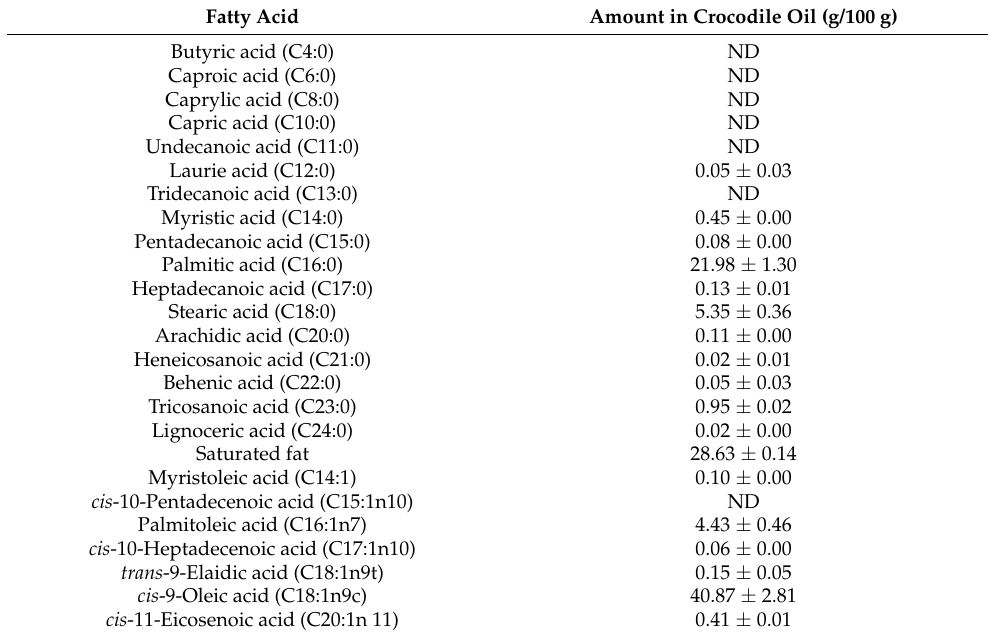
Table 1. Fatty acid composition of crocodile